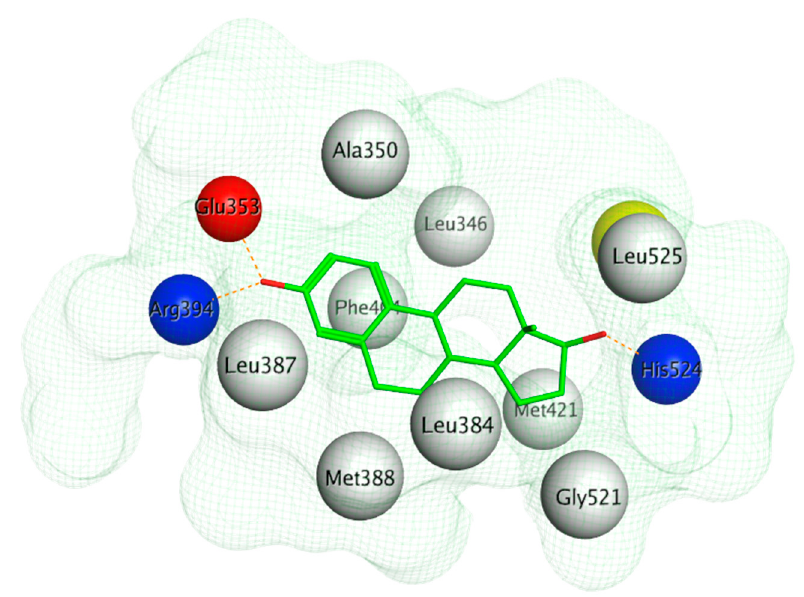
Figure 3. E2 (Green) bound to wild-type ER α at the EBS (pdb: 1QKU). The hydrogen bonds are depicted using dashed lines (orange). E2 forms two hydrogen bonds on one side with Arg394 and Glu353 and forms one on the other side with His524.